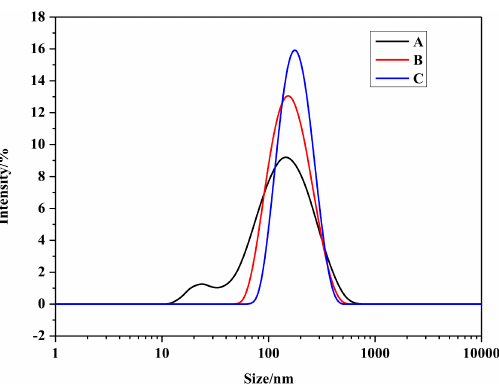
Figure 8. Intensity size distribution: ( A ) tBP3 (DL = 0); ( B ) A 1 -tBP3 (DL = 5.1%) and ( C ) A 2 -tBP3 (DL = 7.9%).